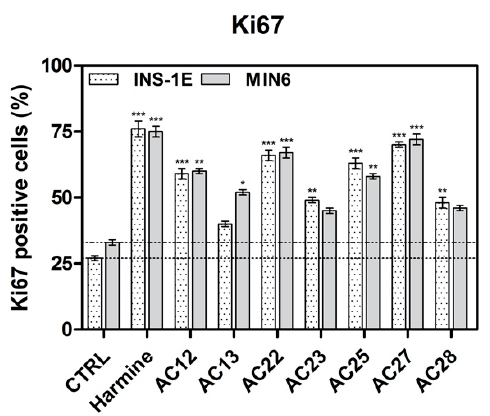
Figure 5. Analysis of the influence of DYRK1A inhibitors on proliferation of INS-1E and MIN6 cells. In Ki67 staining, 5 μ M of each inhibitor and harmine as a positive control were used. Data are ex- pressed as mean ±SEM; * p < 0.05, ** p < 0.01, *** p < 0.001 compared to the control.